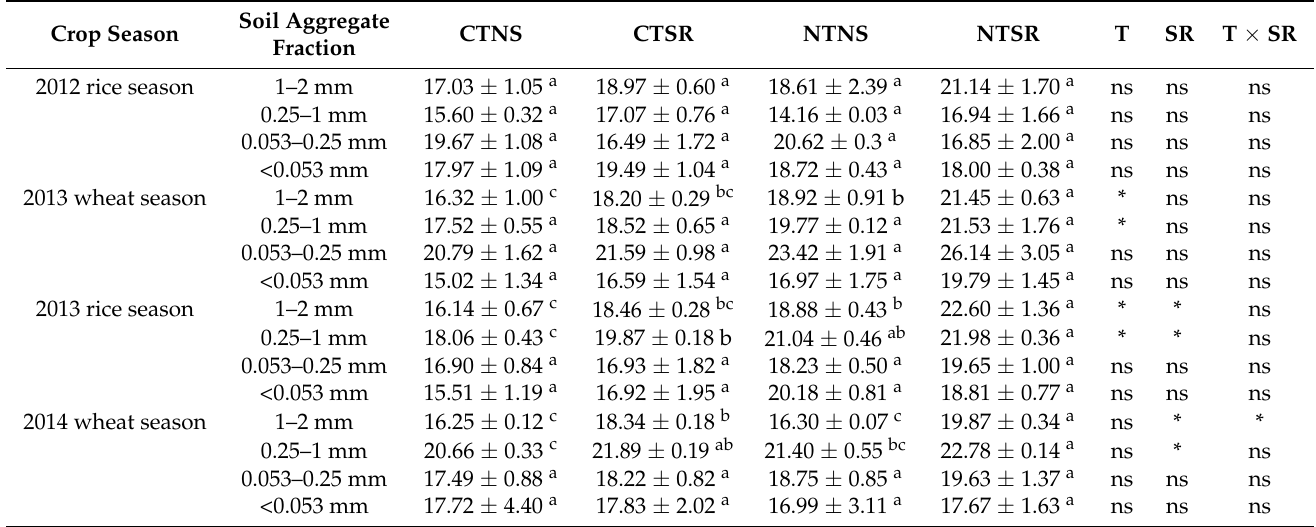
Table 1. SOC contents (g kg − 1 ) of aggregate fractions under different tillage and straw return practices